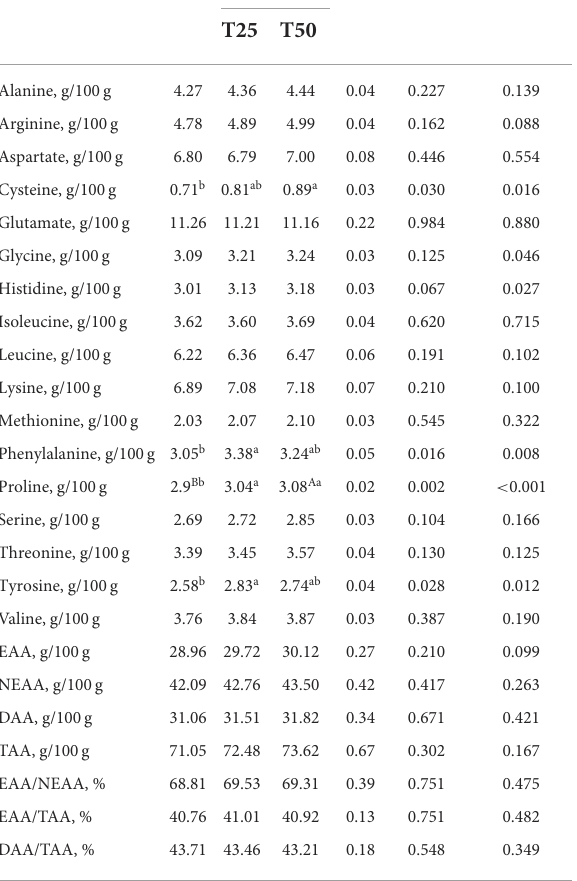
TABLE 7 Effects of different proportions of FPR on the amino acid composition of Simmental bull.